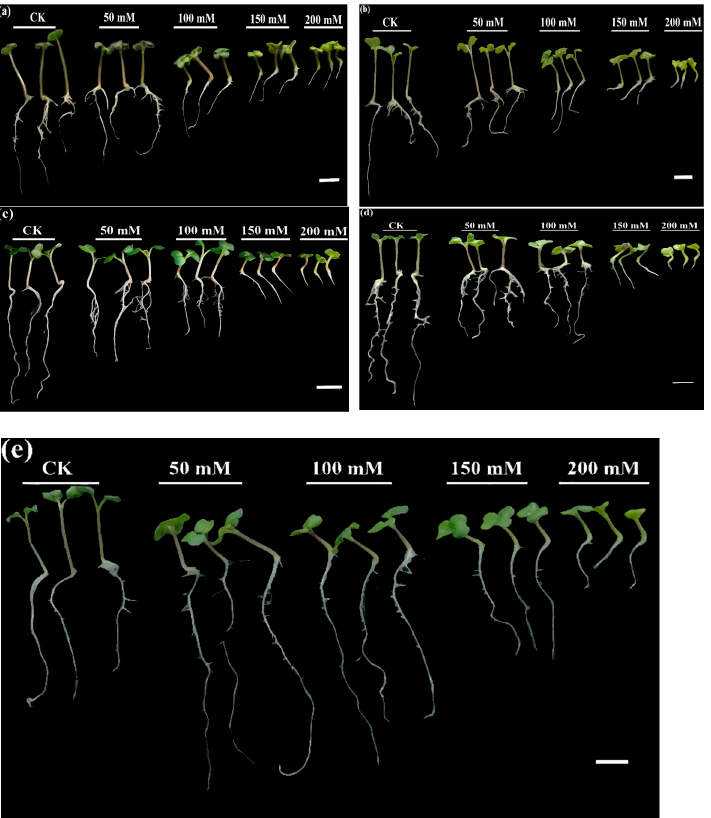
Figure 1. Impact of NaCl treatment on seedling growth of ( a ) Yangza 11, ( b ) Zhongshuang 11, ( c ) Huayouza 62, ( d ) Fengyou 520, and ( e ) Yangyou 9 rapeseed cultivars during the early seedling stage. Scale bar: 1 cm.